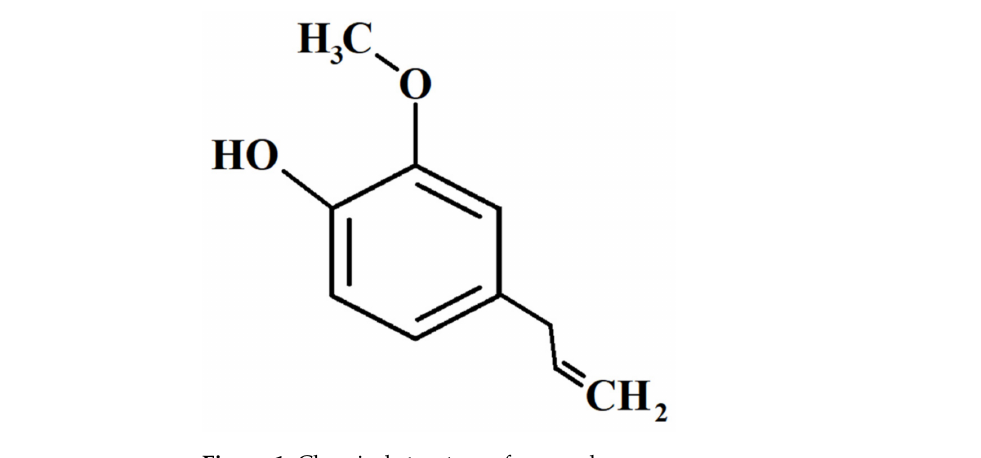
Figure 1. Chemical structure of eugenol.